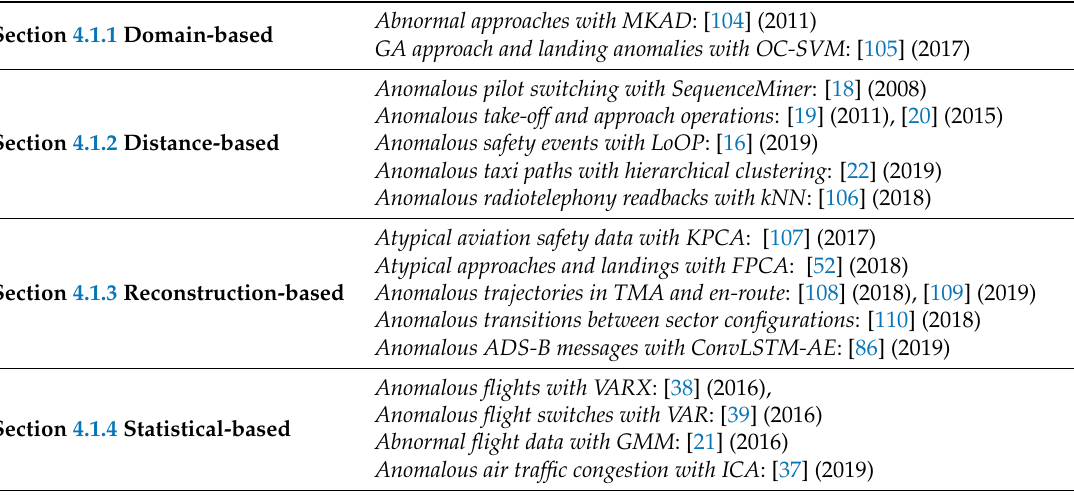
Table 2. Application of anomaly detection models to aviation use